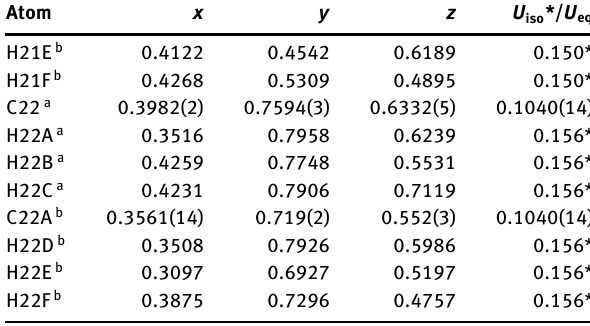
Table 2: Fractional atomic coordinates and isotropic or equivalent isotropic displacement parameters (Å 2